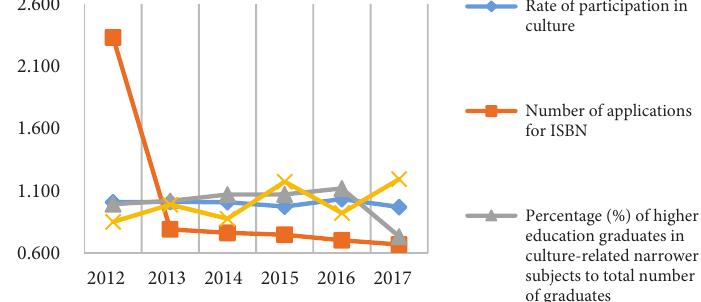
Figure 3. Cultural and educational variables